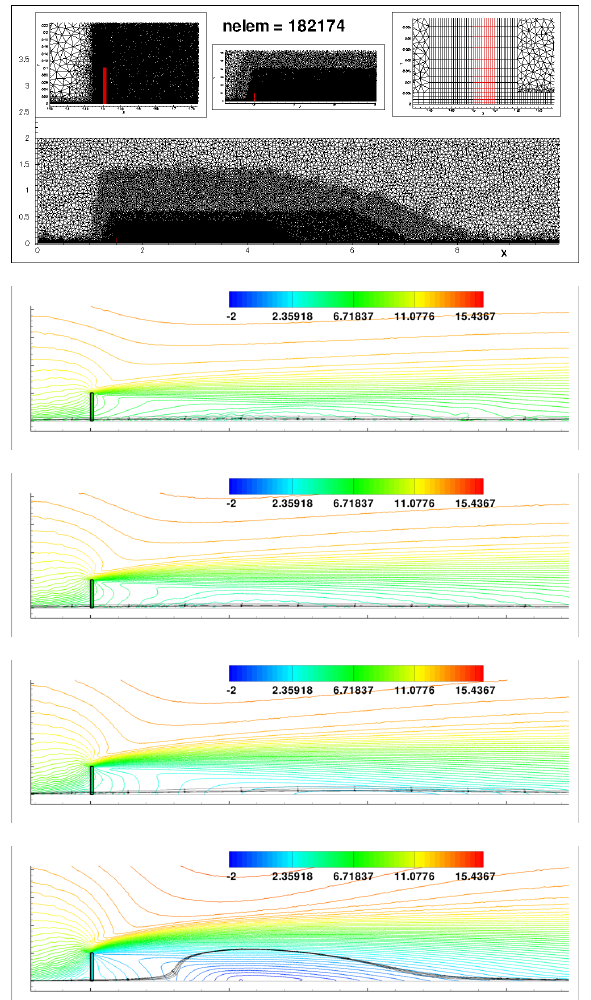
Fig. 3. CFD simulations of the flow through the barrier, regime 1570: isolines of the horizontal velocity component. From top: the used computational mesh, barriers with the porosity 50%, 42%,30%,15%.